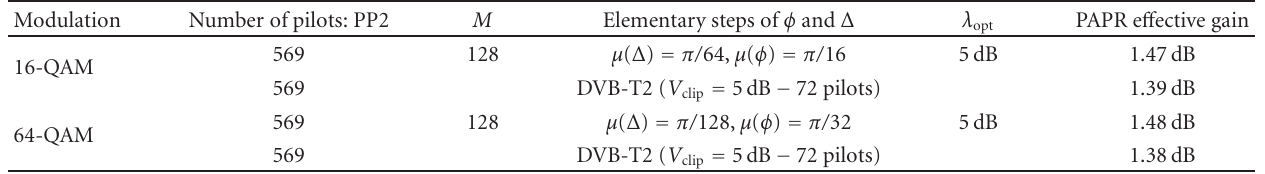
Table 3: Optimal parameters using the proposed technique, 8K